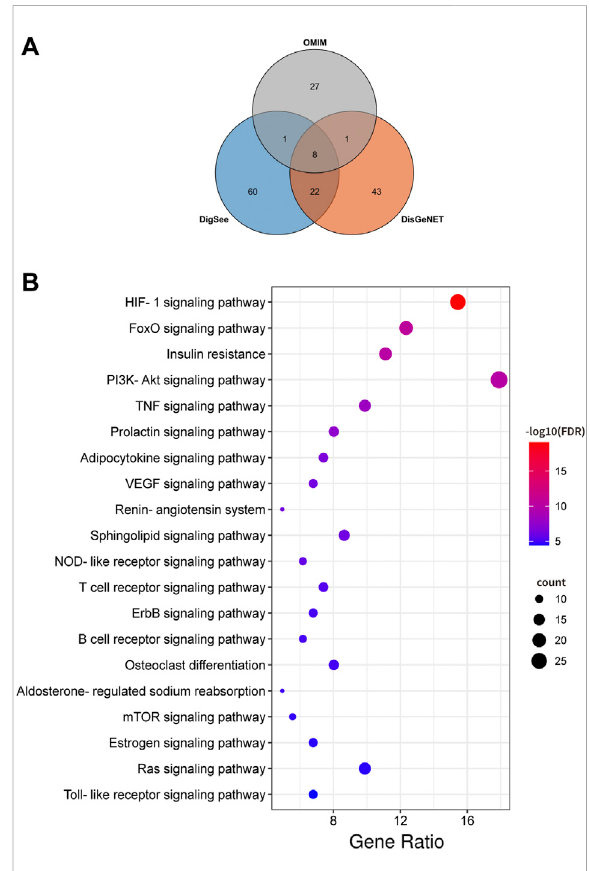
FIGURE 2 DKD targets and Kyoto Encyclopedia of Genes and Genomes (KEGG) enrichment analysis. (A) Venn diagram composed of the OMIM database retrieved DKD targets, DigSee database retrieved DKD targets and DisGeNET database retrieved DKD targets. (B) Dot bubble plot of the top 20 KEGG pathways enriched by the targets of DKD. The size of these dots represents the number of enriched genes, and the color represents the − log 10